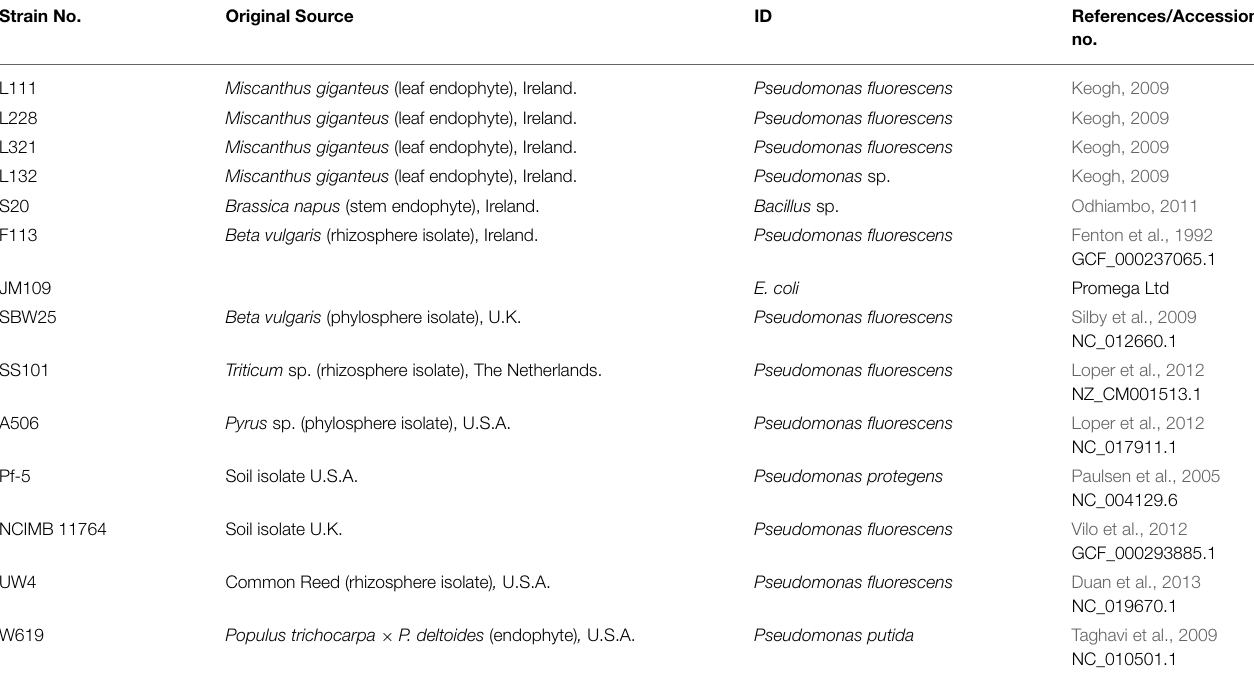
TABLE 1 | Bacterial cultures and genomes used in this study. Strain